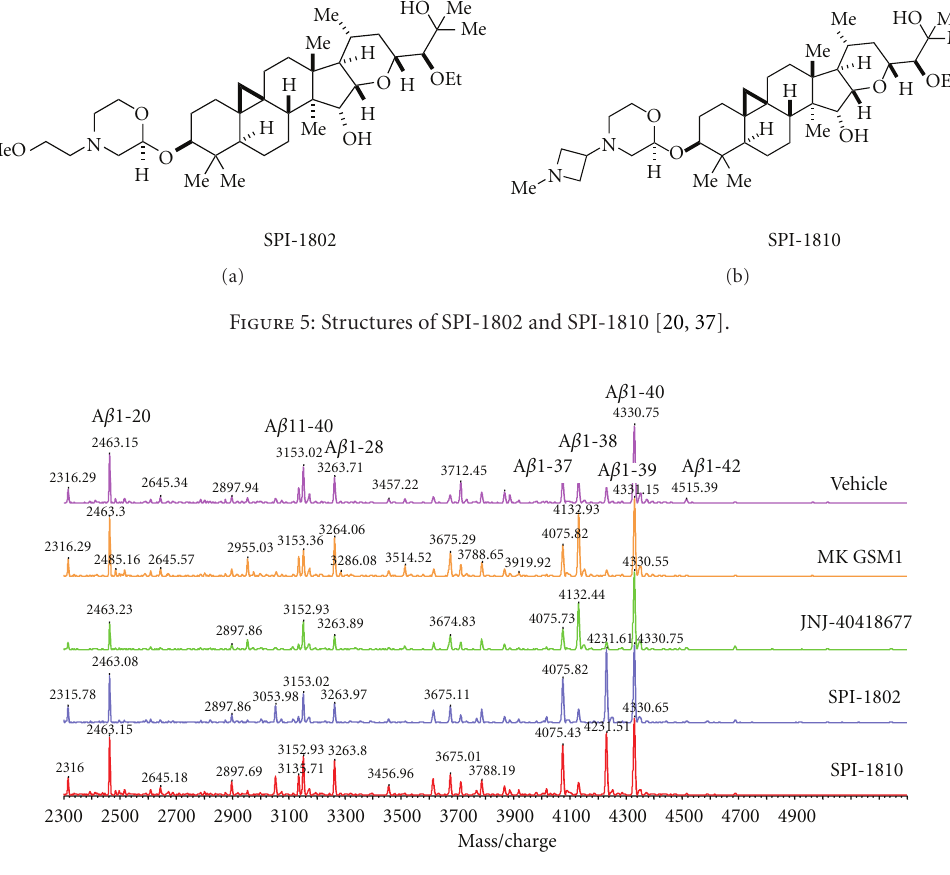
Figure 6: MALDI-TOF analysis of A β peptides from conditioned media of APP-overexpressing CHO cells treated with GSMs. The immunoprecipitated A β peptides were subjected to MALDI-TOF analysis to visualize individual A β fragments. Using a combination of two A β antibodies, 6E10, and 4G8 allows precipitation of full length and N- and C-terminal truncated A β